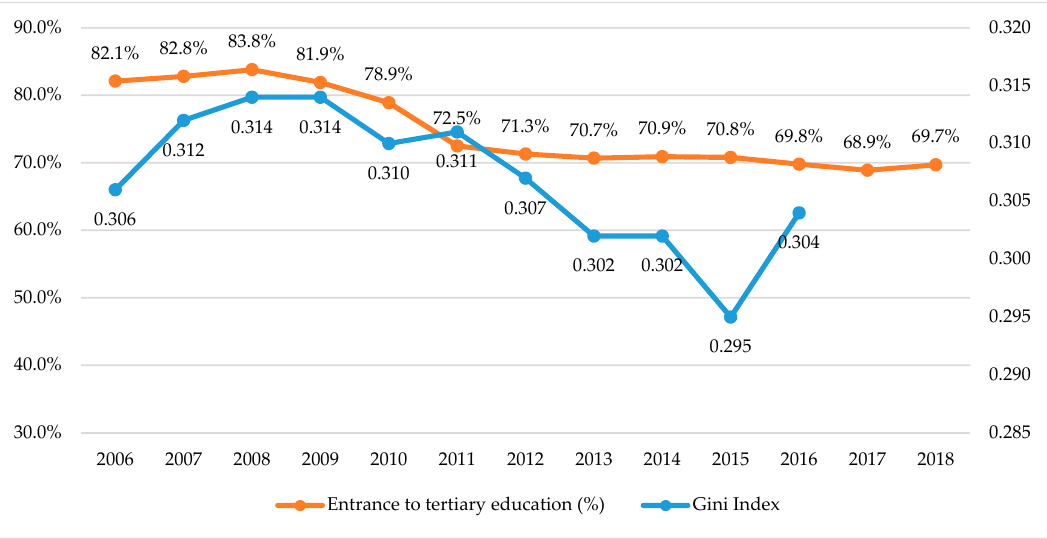
Figure 3. Changes in social index related to economic status and school achievement.